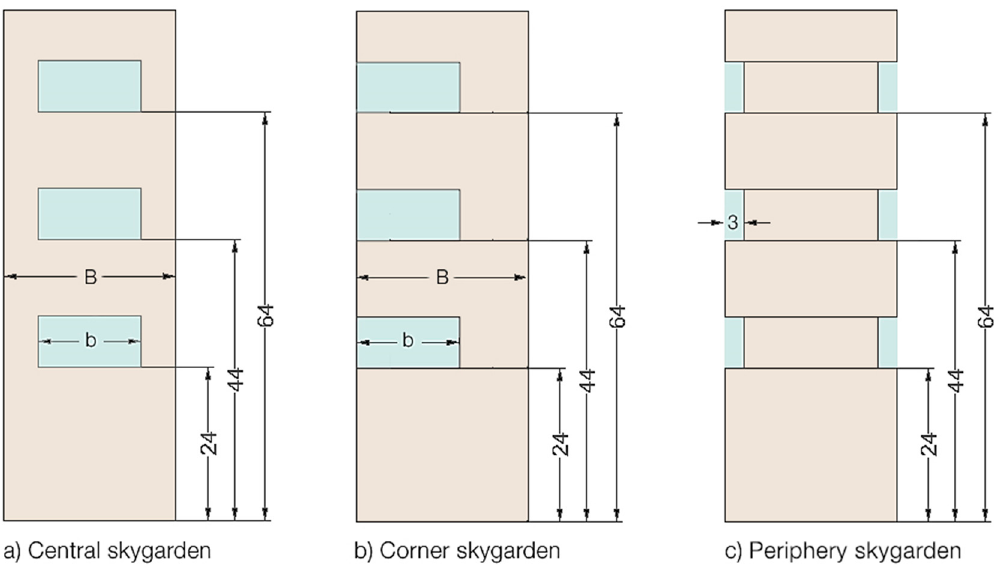
Figure 2. Spatial dimensions of the modelled high-rise building with sky gardens (dimension in metres).